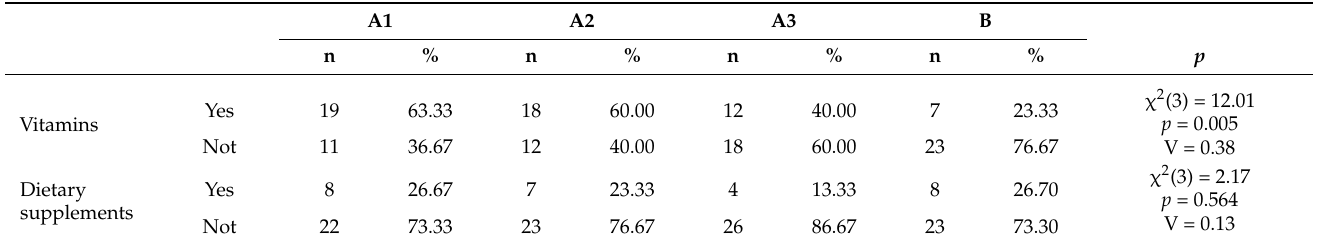
Table 4. Characteristics of regularity of vitamins and dietary supplements taking in groups A1, A2, A3, and B.